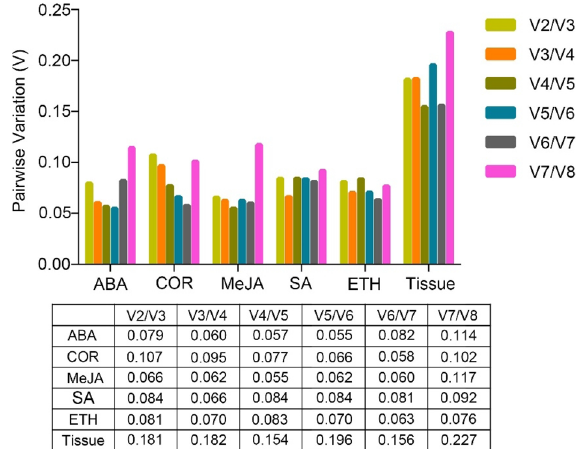
Figure 4. Optimal number of reference genes in different samples from various treatments and tissues using geNorm. Pairwise variation (V) was calculated to obtain the minimum number of reference genes required for normalization under each experimental condition. ABA, abscisic acid; COR, coronatine; MeJA, methyl jasmonate; SA, salicylic acid; ETH, ethylene. The figure was generated by GraphPad Prism 9 (version 9.0.0; https ://www.graph pad.com/).